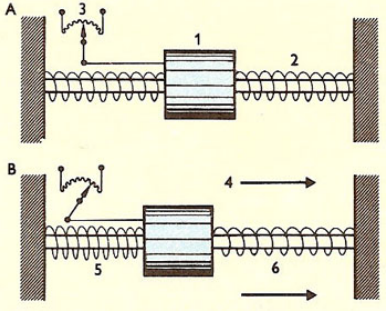
Figure 6. Basic electromechanical linear accelerometer (Source: IEEE GlobalSpec, 2016)